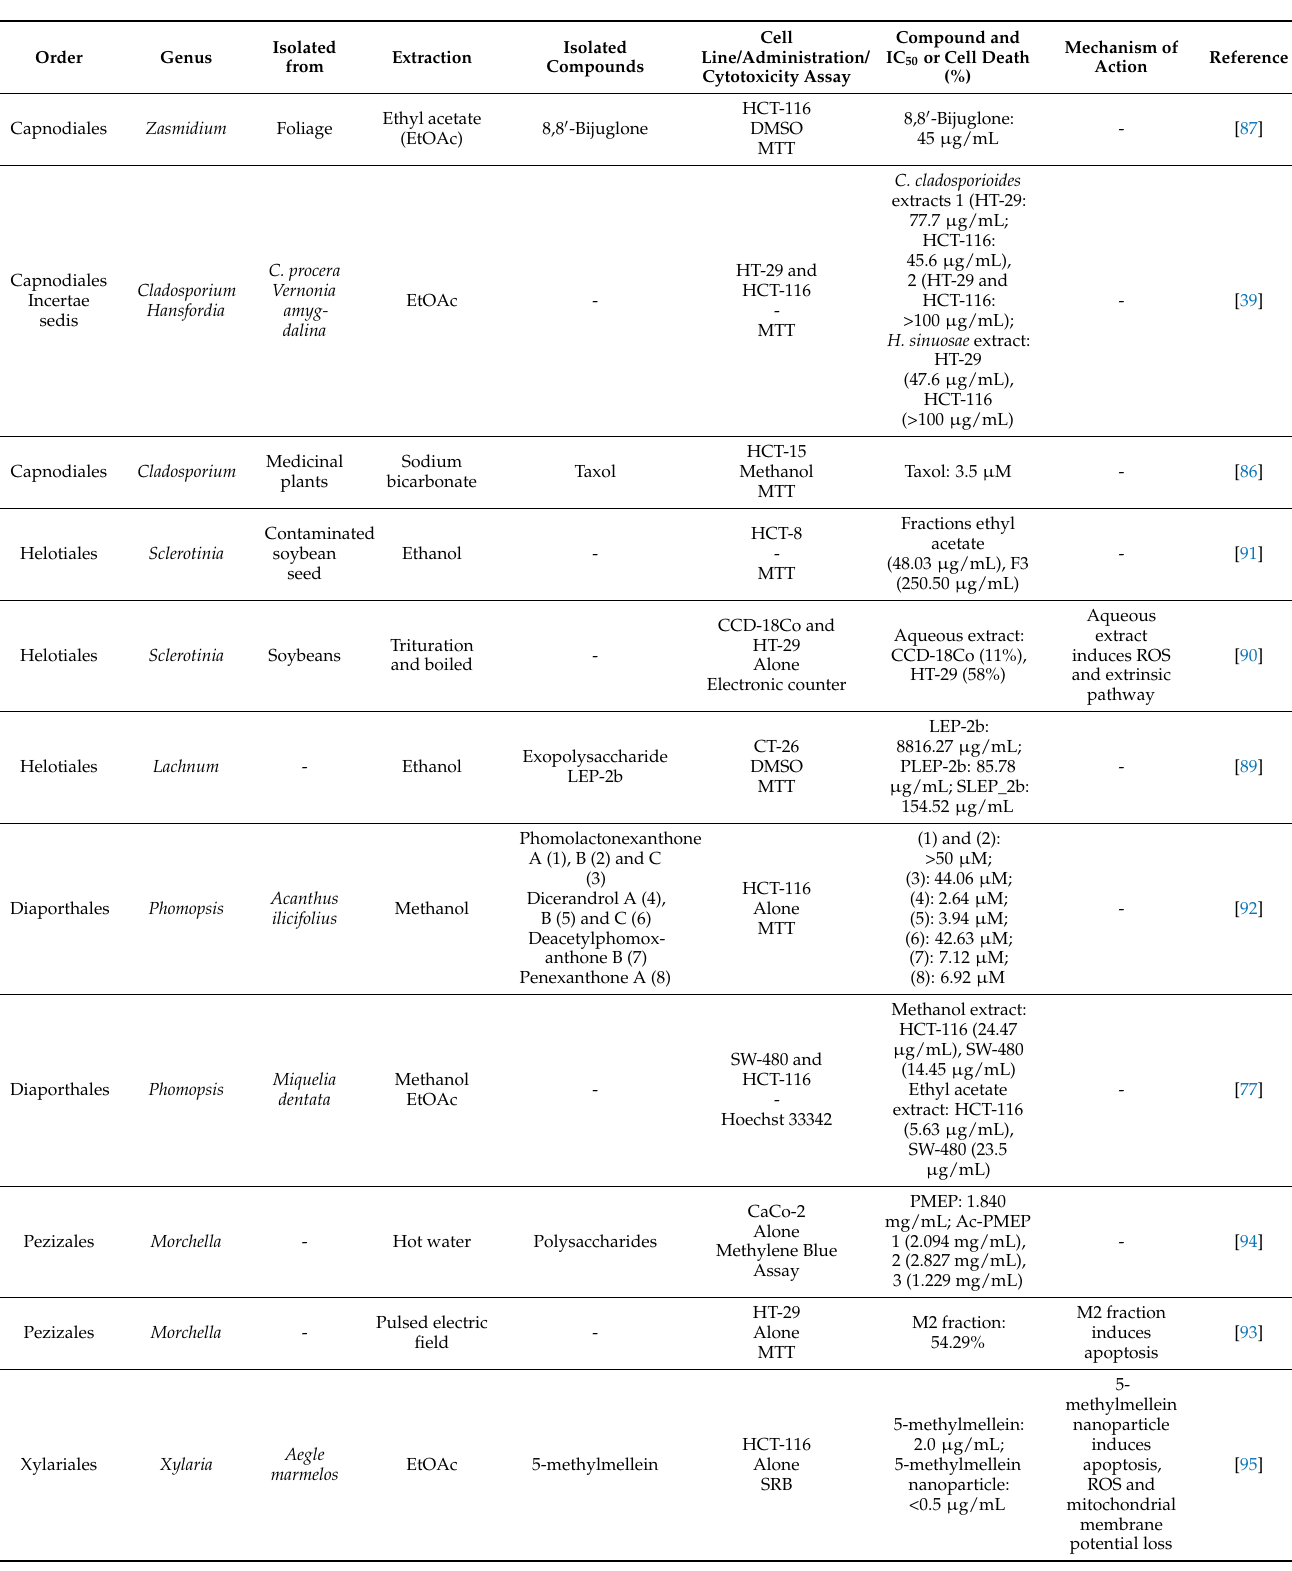
Table 5. Antitumor activity of the extracts or isolated compounds from Minoritary orders in CRC cancer cell